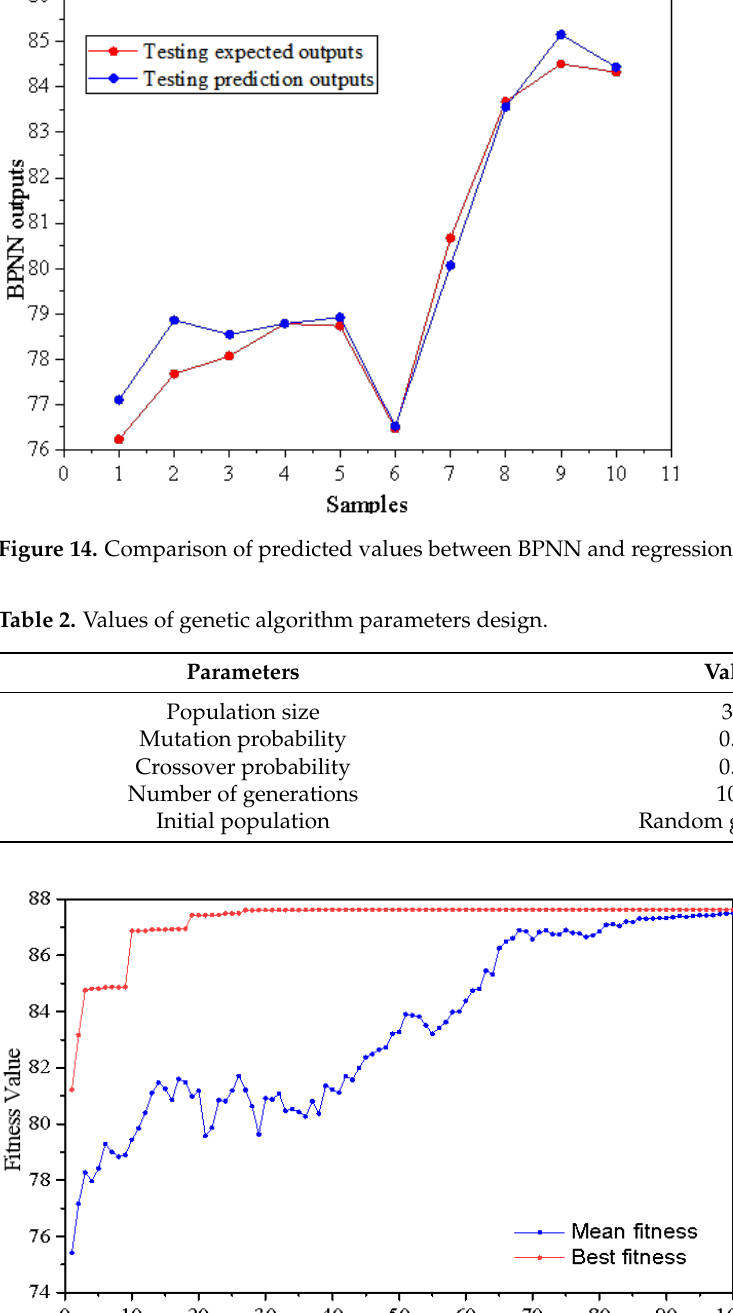
Figure 14. Comparison of predicted values between BPNN and regression analysis.